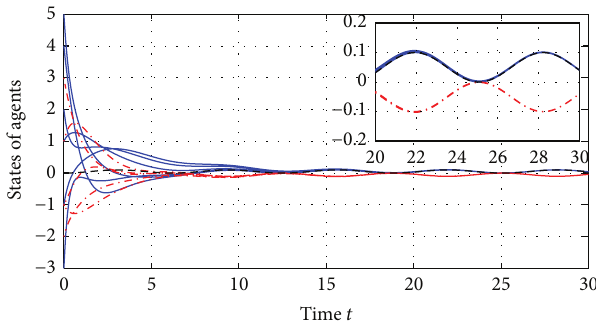
Figure 6: State evolution of agents on the structurally balanced coopetition network G 𝑠